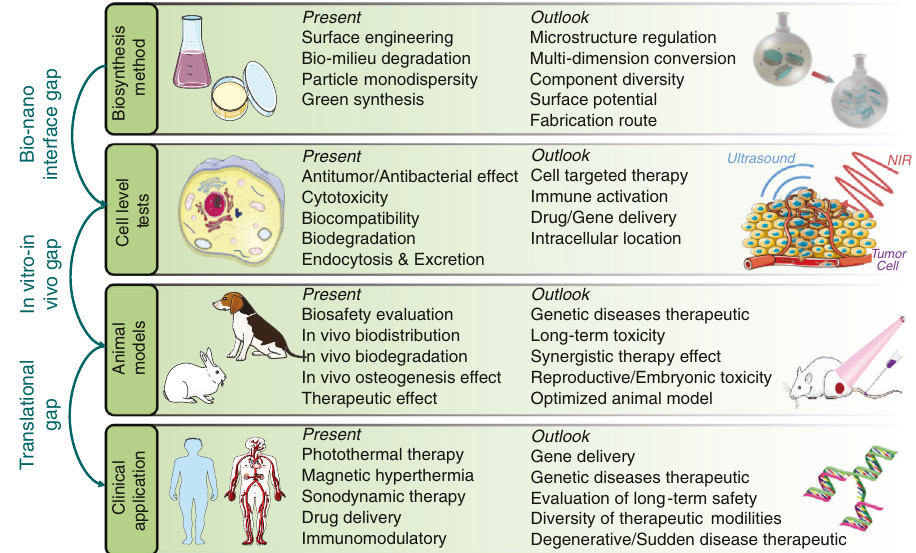
Fig. 12 Summative scheme of the current research developments and the future outlook in smart stimuli-responsive biomaterials with multiple functions of bone therapeutics and bone